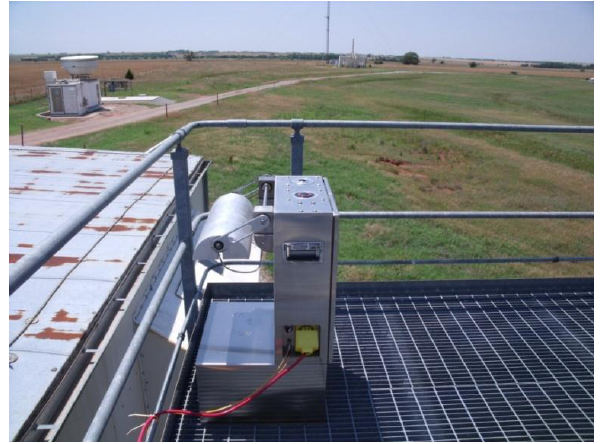
Figure 1. ASIVA at SGP Guest Instrument Facility from May 21 to July 27, 2009. 3 Fig. 1. ASIVA at SGP Guest Instrument Facility from 21 May to 27 July 2009.